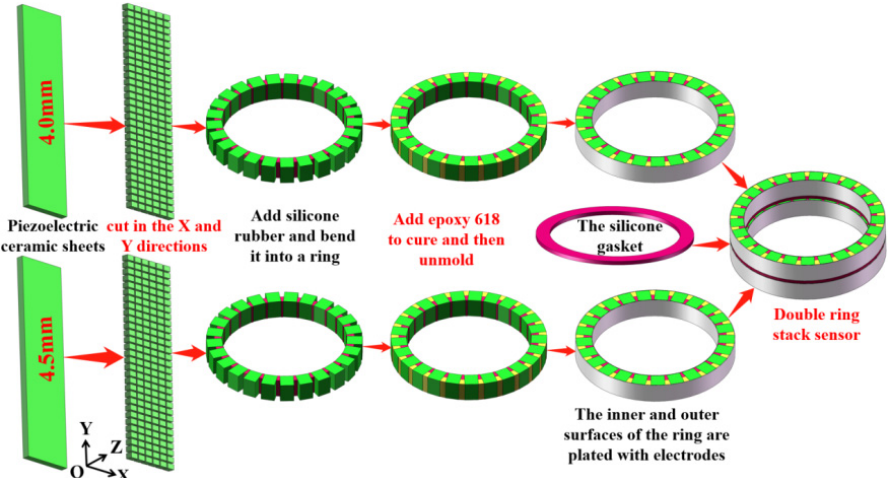
Figure 6. Fabrication flowchart of the double-ring stacked sensing element.